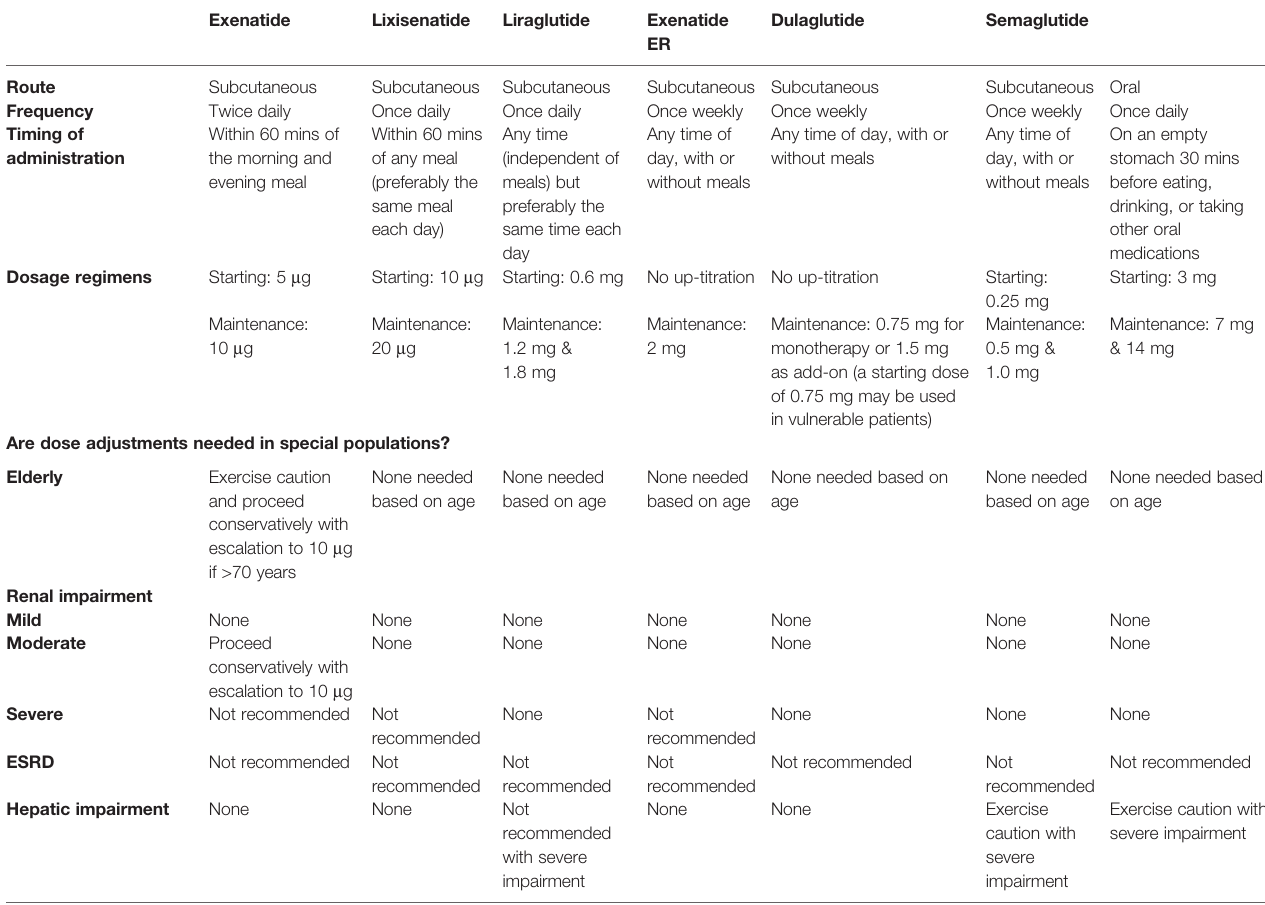
TABLE 1 | Summary of the clinical particulars of available GLP-1RAs (20 –